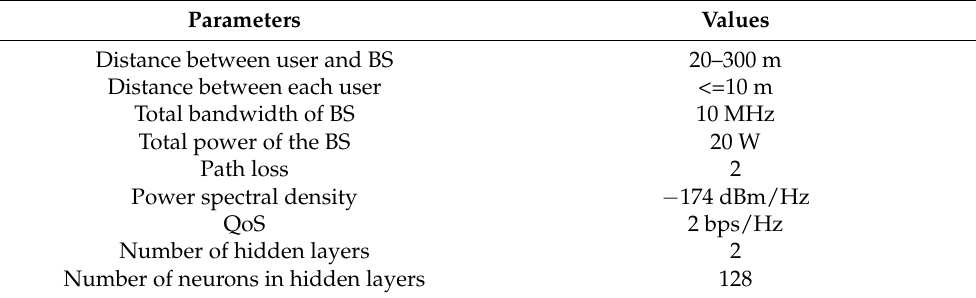
Table 1. Parameter